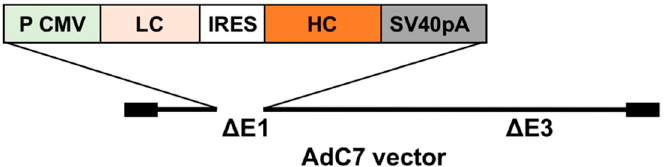
Figure 1. Schema of the chimpanzee adenovirus type 7 vector expressing murine anti-respiratory syncytial virus antibody (AdC7 α RSV) . The E1/E3 genes of AdC7 are deleted ( Δ E1/ Δ E3) and replaced by the expression cassette of the anti-RSV antibody cDNAs using the restriction enzyme sites I-CeuI and PI-SceI. The expression cassette includes the cytomegalovirus promoter (P CMV), followed by cDNAs encoding the anti-RSV light chain (LC), the poliovirus internal ribosome entry site (IRES), the anti-RSV heavy chain (HC), and SV40 polyadenylation signal (SV40 pA).